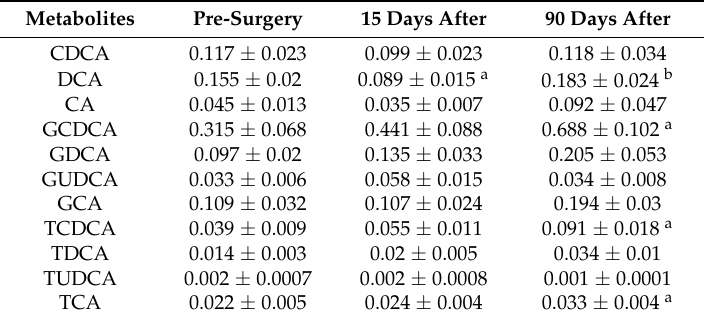
Table A2. Bile acid concentration ( µ M) in dried blood spots from patients before, 15 days and 90 days after RYGB. CDCA: chenodeoxycholic acid; DCA: deoxycholic acid; CA: cholic acid; GCDCA: glycochenodeoxycholic acid; GDCA: glycodeoxycholic acid; GUDCA: glycoursodeoxycholic acid; GCA: glycocholic acid; TCDCA: taurochenodeoxycholic acid; TDCA: taurodeoxycholic acid; TUDCA: tauroursodeoxycholic acid; TCA: taurocholic acid. Primary: sum of CDCA, CA, GCDCA, GCA, TCDCA and TCA; Secondary + Tertiary: sum of DCA, GDCA, GUDCA, TDCA and TUDCA; Glyco: sum of all glycine-conjugated BA; Tauro: Sum of all taurine-conjugated BA. Values represent mean ± SEM. a p < 0.05 compared to pre-surgery; b p < 0.05 compared to 15 days.